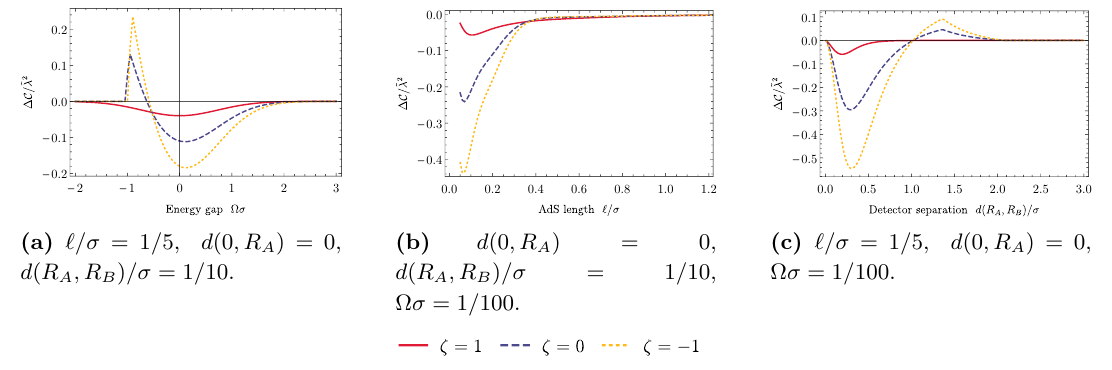
Figure 15 . A series of plots characterizing the di(cid:11)erence in concurrence (cid:1) C := C circular (cid:0) C static between static detectors and detectors on circular geodesic orbits around the origin. Plot (a) shows the di(cid:11)erence (cid:1) C = ~ (cid:21) 2 as a function of the detectors energy gap (cid:10) (cid:27) for (cid:12)xed AdS length ‘=(cid:27) and detector separation d ( R A ; R B ) when detector A is located at the origin. Plot (b) shows the di(cid:11)erence (cid:1) C = ~ (cid:21) 2 as a function of AdS length ‘=(cid:27) for (cid:12)xed detector energy gap (cid:10) (cid:27) and proper separation d ( R A ; R B ) when detector A is located at the origin. Plot (c) shows the di(cid:11)erence (cid:1) C = ~ (cid:21) 2 as a function of proper detector separation d ( R A ; R B ) for (cid:12)xed AdS length ‘=(cid:27) and detector energy gap (cid:10) (cid:27) when detector A is located at the